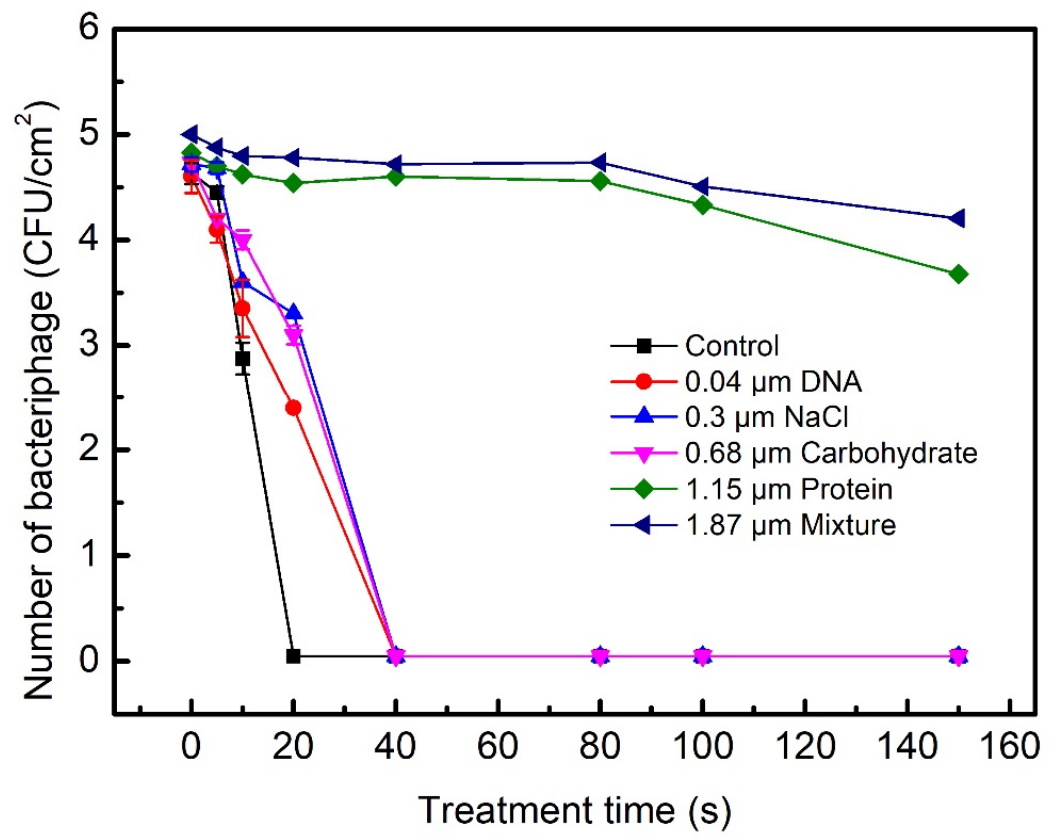
Figure 4. The number of surviving bacteriophages in the biofilms containing proteins, carbohydrates, DNA, salt or their mixture as a function of the plasma treatment time. The plasma inactivation was performed at V PP = 8.25 kV and a power of 460 W; 10 µ L of the aqueous solutions containing bacteriophage and constituents of biofilms was spread onto each steel disc (1.0 cm 2 ) and placed for 10 min under air flow in a biosafety cabinet to allow drying. After drying, the thicknesses of proteins, carbohydrates, DNA, salt, and their mixed biofilms were 1.15 µ m, 0.68 µ m, 0.04 µ m, 0.3 µ m, and 1.87 µ m, respectively. The mixed biofilms contained 2% DNA, 19% NaCl, 29% carbohydrates, and 50% proteins. The steel discs with dry biofilms were placed into the humidified air DBD chamber for plasma inactivation. Means ± standard deviations of experiments carried out at least in triplicate are shown. After the deacetylation of H2DCFDA in the NaOH solution, the non-fluorescent form (2,7-dichlorodihydrofluorescein, DCFH) can be oxidized into the highly fluorescent form 2,7-dichlorofluorescein (DCF) by the RONS from the gas phase [15]. The fluorescence spectra of DCF at 521 nm are shown in Figure 6. The fluorescence intensity of DCF in the aqueous solution significantly increased with an increase in the treatment time, confirming that DCFH was oxidized into DCF by the RONS from the gas